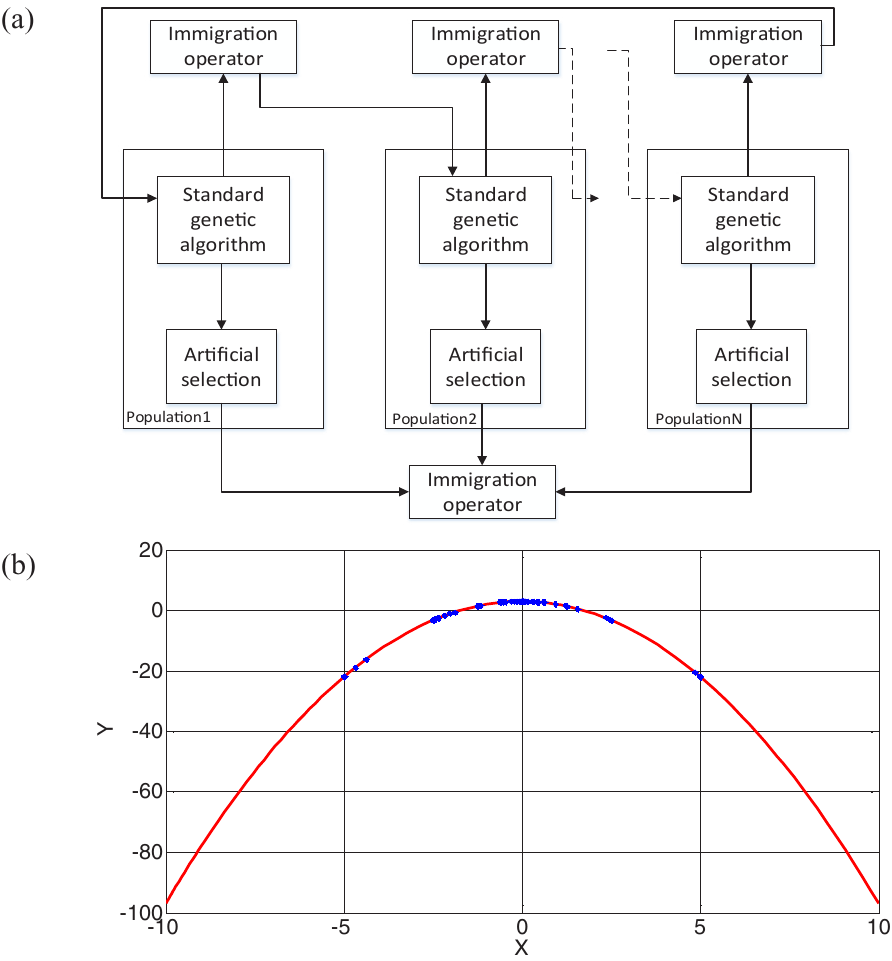
Figure 2: Flow diagram of MPGA (a) and function optimization result diagram